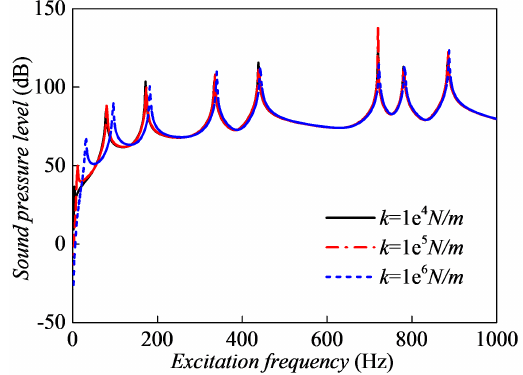
Figure 9: The comparison of sound pressure level with C-C-C-C boundary